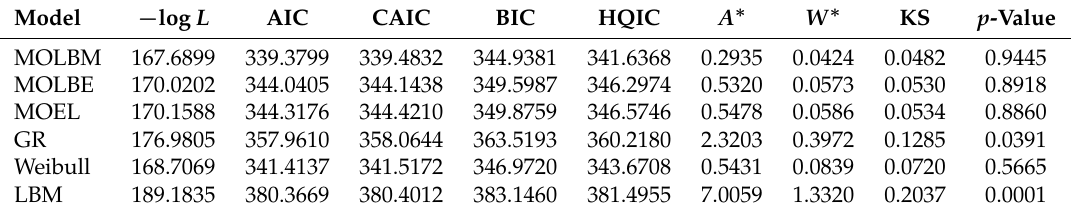
Table 10 indicates the − log L , AIC, CAIC, BIC, HQIC, A ∗ , W ∗ , KS and p -value of the considered models. Table 10. Some criteria and goodness of fit measures for Data set